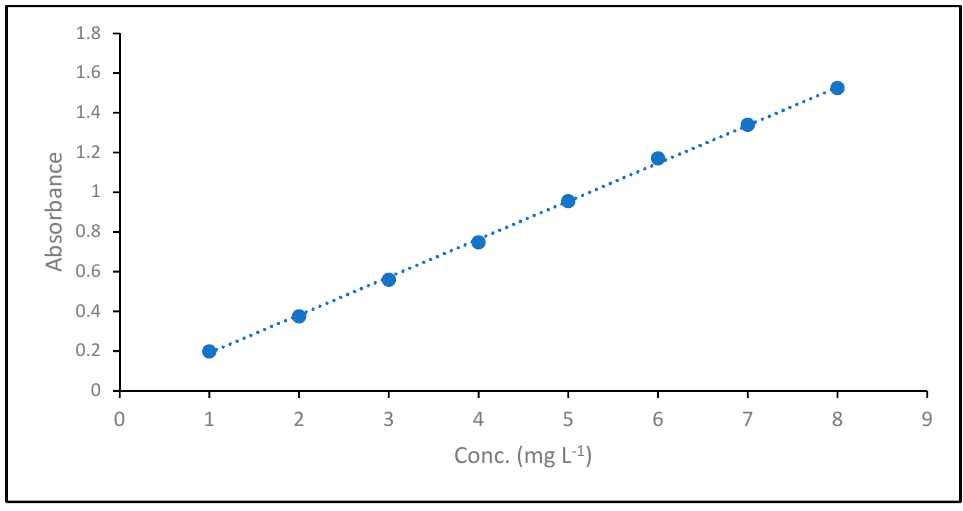
Figure 2. Absorption Coefficient of MB dye.